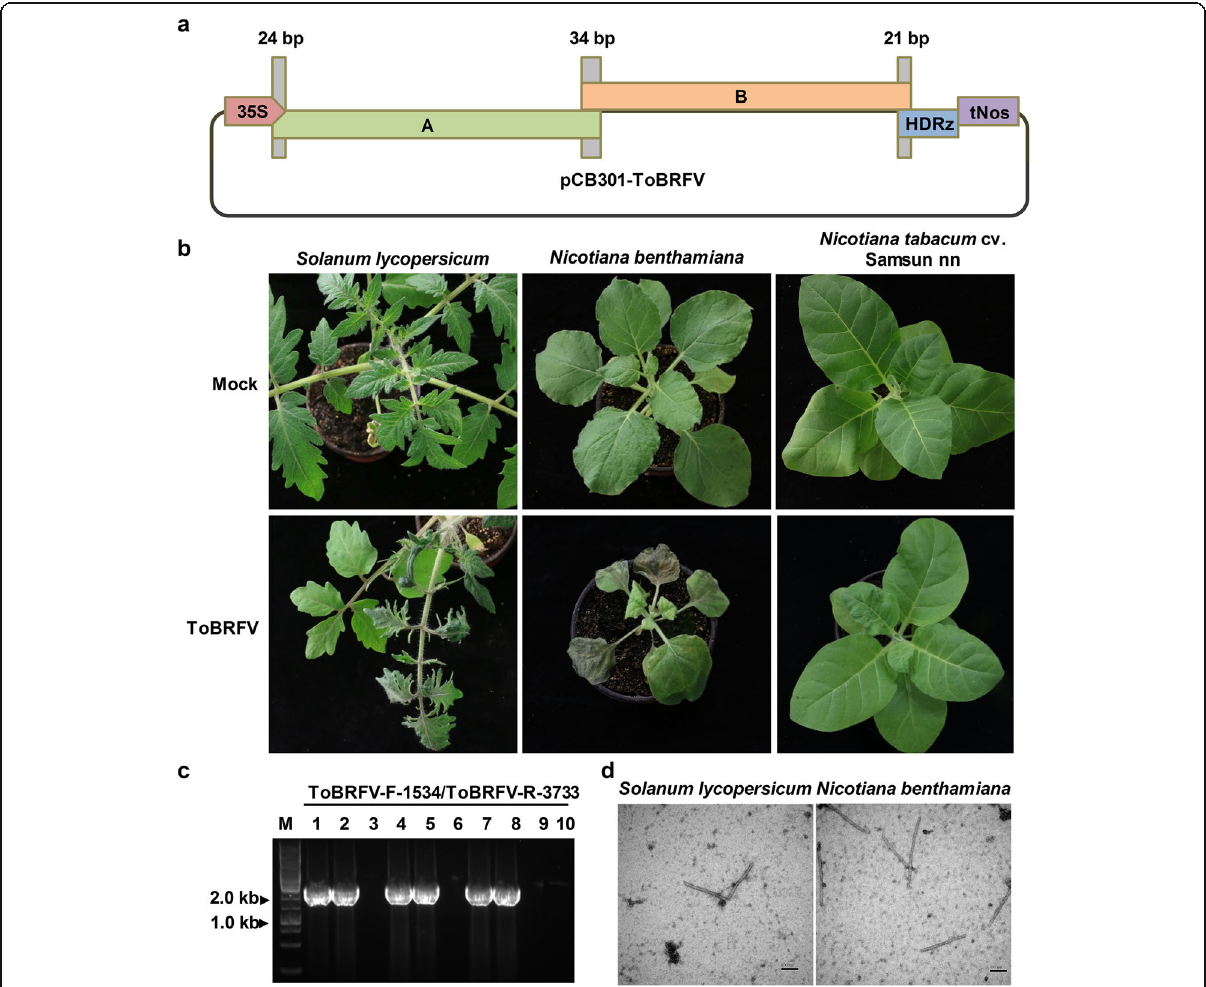
Fig. 4 Infectivity and pathogenicity of the infectious clone of ToBRFV. a Schematic diagram illustrating the one-step assembly cloning strategy used for the construction of an infectious full-length cDNA clone of ToBRFV. Two overlapping ToBRFV fragments, A and B, were amplified by polymerase chain reaction and infused to the linearized pCB301 vector. The overlapping regions were illustrated by gray rectangles, showing the number of overlapping nucleotides. 35S, the cauliflower mosaic virus promoter; HDRz, hepatitis delta virus ribozyme ribozyme; tNos, Nos terminator. b Symptoms in tomato ( Solanum lycopersicum ), Nicotiana benthamiana , and N. tabacum cv. Samsun nn plants induced by ToBRFV infection. In the upper panel, plants were mock-inoculated with agrobacteria harboring the pCB301 vector. In the lower panel, plants were agroinoculated with the infectious clone of ToBRFV (pCB301-ToBRFV). Images were taken at 21 dpi for tomato plants, and 14 dpi for N. benthamiana and N. tabacum cv. Samsun nn plants. c RT-PCR analysis of ToBRFV RNA accumulation in systemic leaves of agroinoculated plants using ToBRFV-specific primers. Lane M, GeneRuler 1 kb DNA ladders (Thermo); lanes 1 – 2, RNA extracted from N. benthamiana plants agroinoculated with pCB301-ToBRFV; lanes 4 – 5, RNA extracted from tomato plants agroinoculated with pCB301-ToBRFV; lanes 7 – 8, RNA extracted from N. tabacum cv. Samsun nn plants agroinoculated with pCB301-ToBRFV. Lanes 3, 6, and 9, represent RNA extracted from mock-inoculated